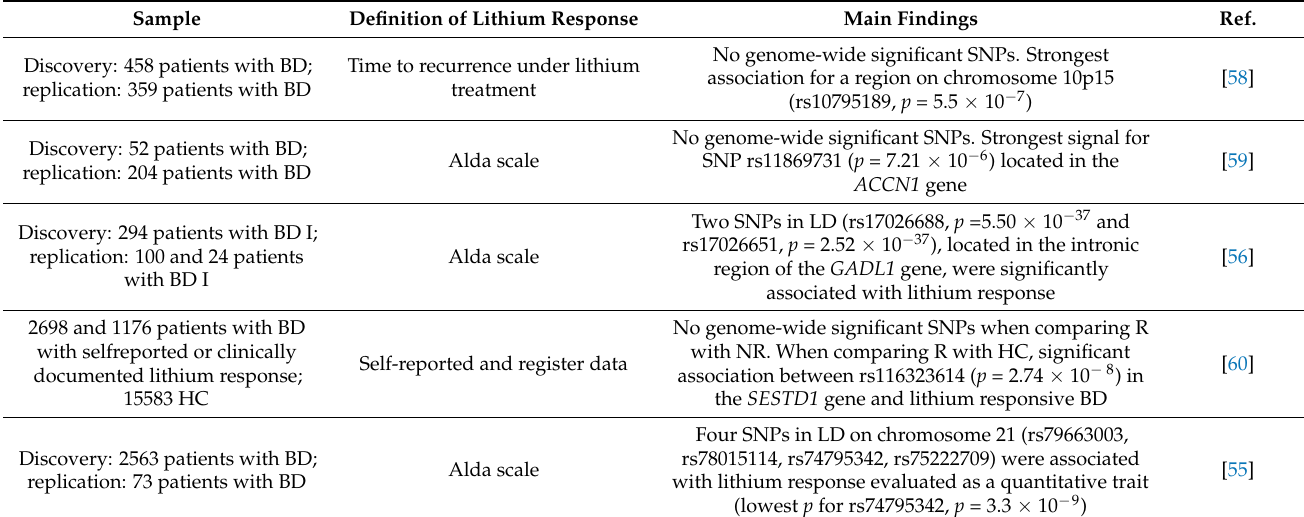
Table 2. GWAS on response to lithium in patients with